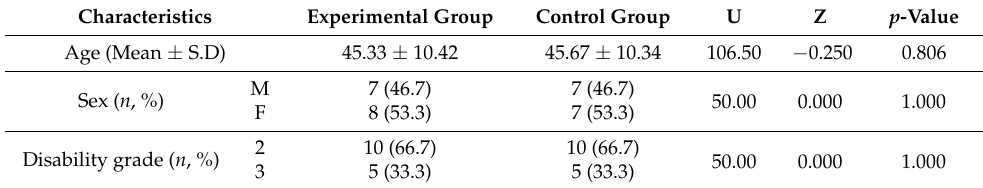
Table 2. Characteristics of subjects.